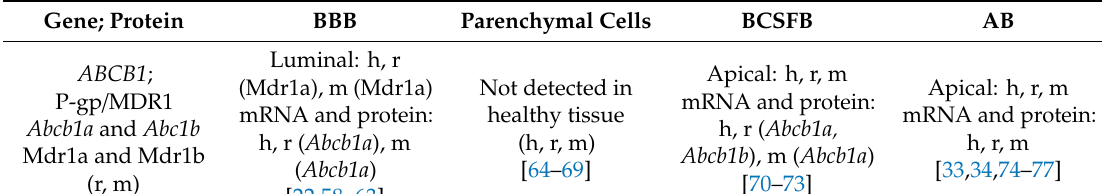
Table 2. Subcellular localization and level of evidence (protein and / or mRNA) of ABC transporters at the brain barriers of humans and rodents under non-pathological